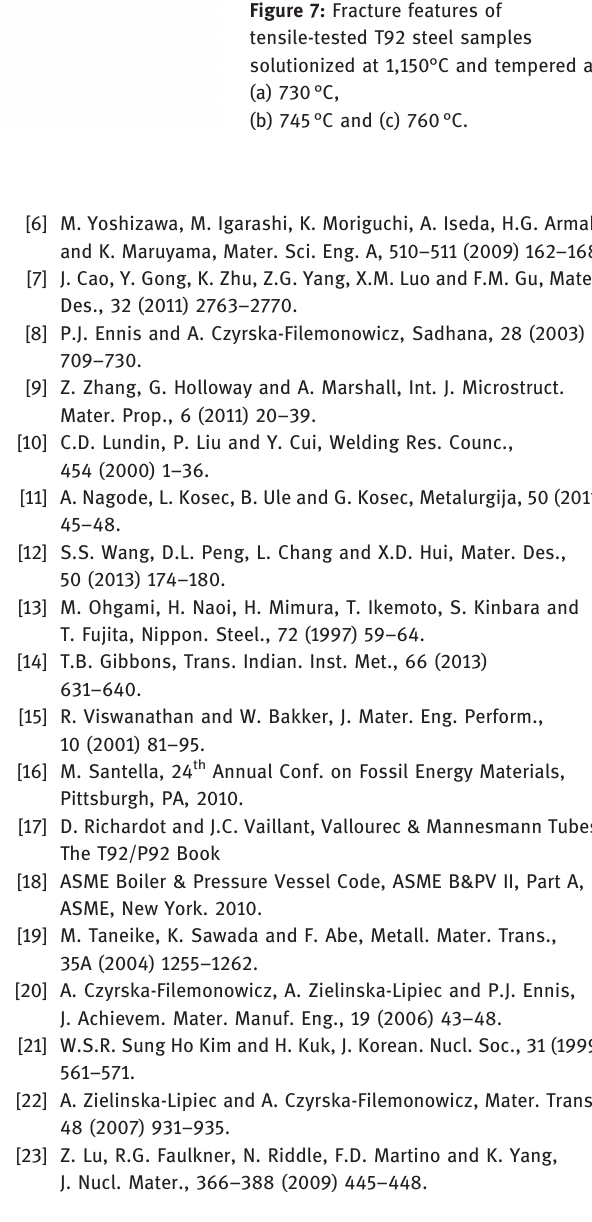
Figure 7: Fracture features of tensile-tested T92 steel samples solutionized at 1,150°C and tempered